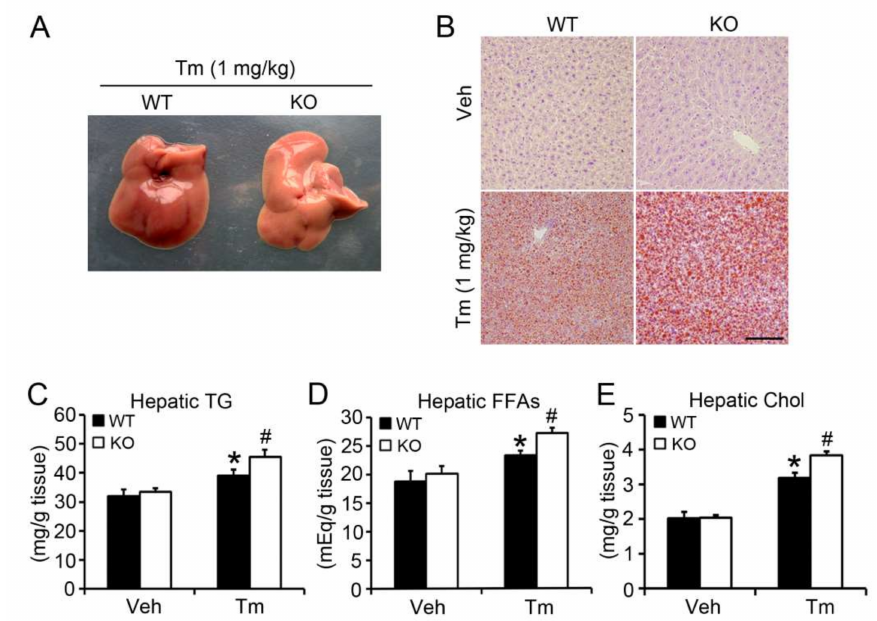
Figure 2. BAP31 deficiency promoted Tunicamycin-induced hepatic lipid accumulation. ( A ) Representative photo of livers from WT and KO mice post Tunicamycin administration for 48 h. ( B ) Representative Oil red O staining of livers from WT and KO mice post Tunicamycin administration for 48 h (200 × , scale bar = 100 µ m). n = 4 per group. Hepatic ( C ) triglycerides (TG), ( D ) free fatty acids (FFAs), and ( E ) cholesterol (Chol) were quantified spectrophotometrically. n = 7–8 per group. Data represent as mean ± SEM. *, p < 0.05, Tm compared with Veh group. #, p < 0.05, KO compared with WT mice injected with Tm. Table 1. Serum metabolites of mice after Tunicamycin administration for 48 h. Vehicle Variable